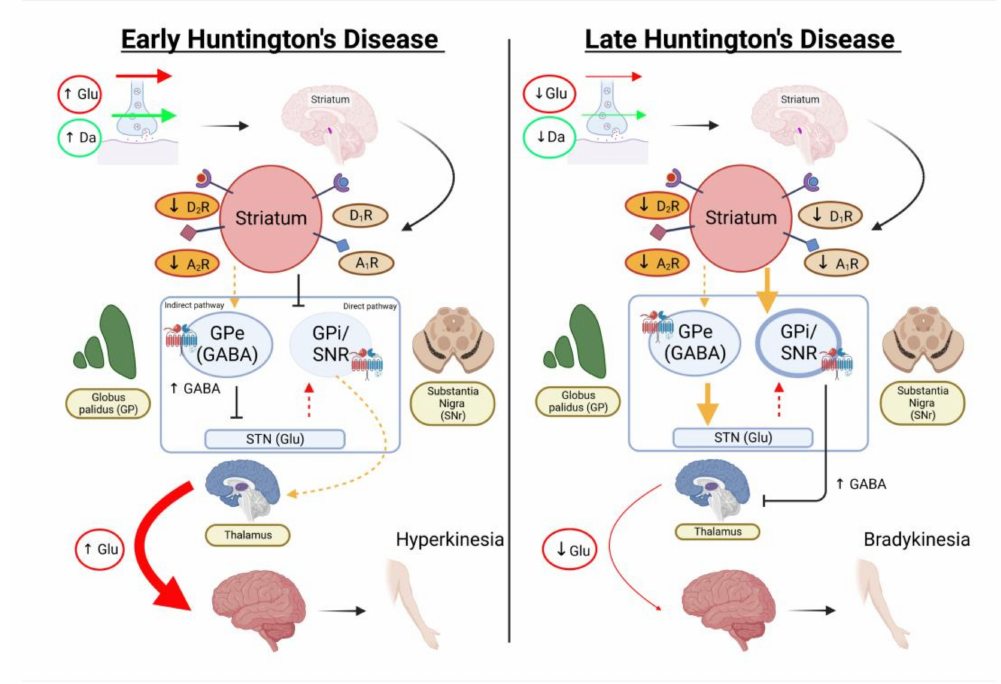
Figure 2. Pathophysiology of Huntington’s disease. In the early stage, the aggregates delay axonal transport, resulting in a failed delivery of GABA(A), which inhibits the synaptic excitability of the subthalamic nucleus. As a result, the compensatory mechanism of the thalamus leads to hyperkinesia. In the late stage, the trafficking of NMDA receptors in striatal neurons is affected and may cause an imbalance between synaptic and extrasynaptic NMDA receptors. This leads to excitotoxicity either due to increased glutamate or impaired uptake and clearance. Ultimately, bradykinesia is observed (created with BioRender.com) (accessed on 5 January